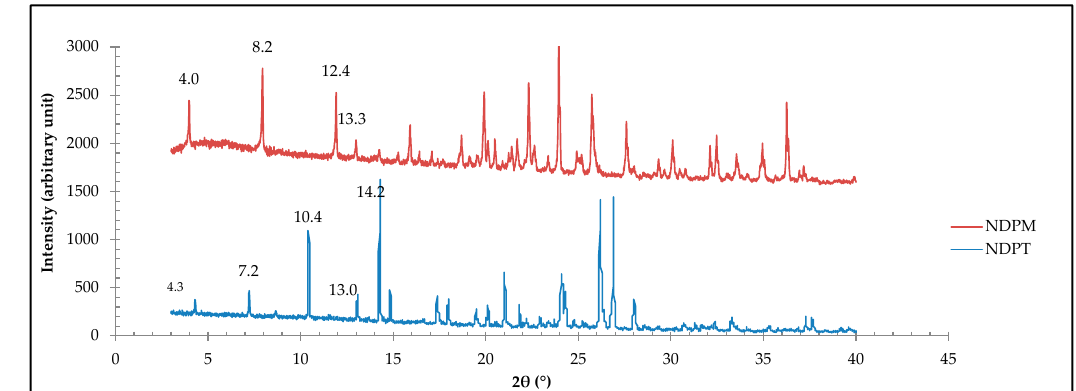
Figure 11. The measured diffraction pattern of NDPM (red) shows the different profile compared to NDPT (blue).